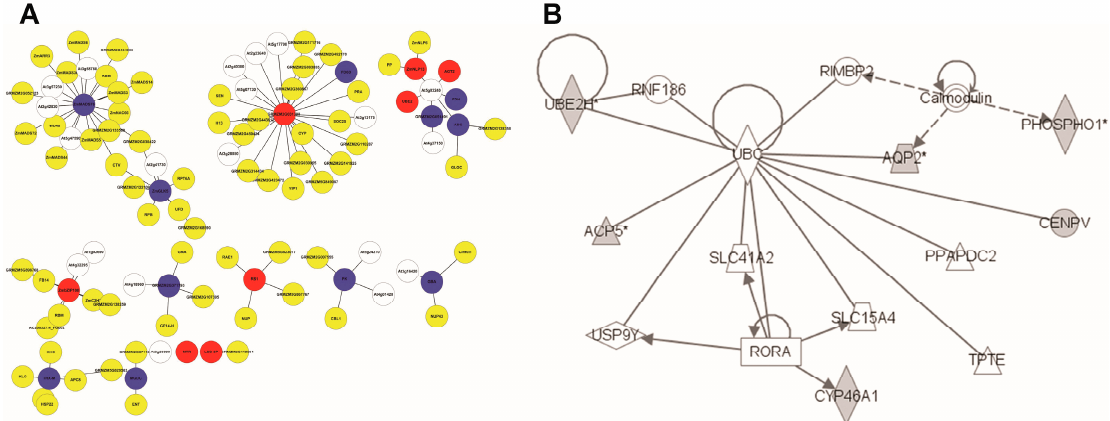
Figure 3. The known network of maize N response genes from Study 1. ( A ) The Biological General Repository for Interaction Datasets (BioGRID) network with maize N response genes: 108 genes with 97 interactions retrieved. Nodes in white represent genes only mapped in Arabidopsis ; nodes in yellow represent genes with no expression difference; nodes in blue represent down-regulated genes; and nodes in red represent up-regulated genes. ( B ) The IPA network with N response genes. The grey nodes are from the input set of nine genes.